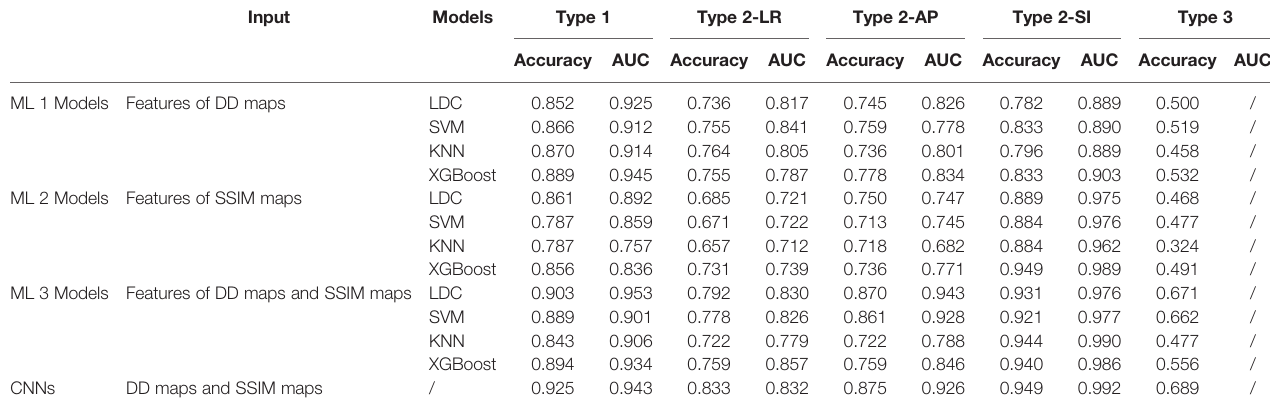
TABLE 2 | Classi fi cation accuracy and AUC values of ML 1, 2, and 3 models and